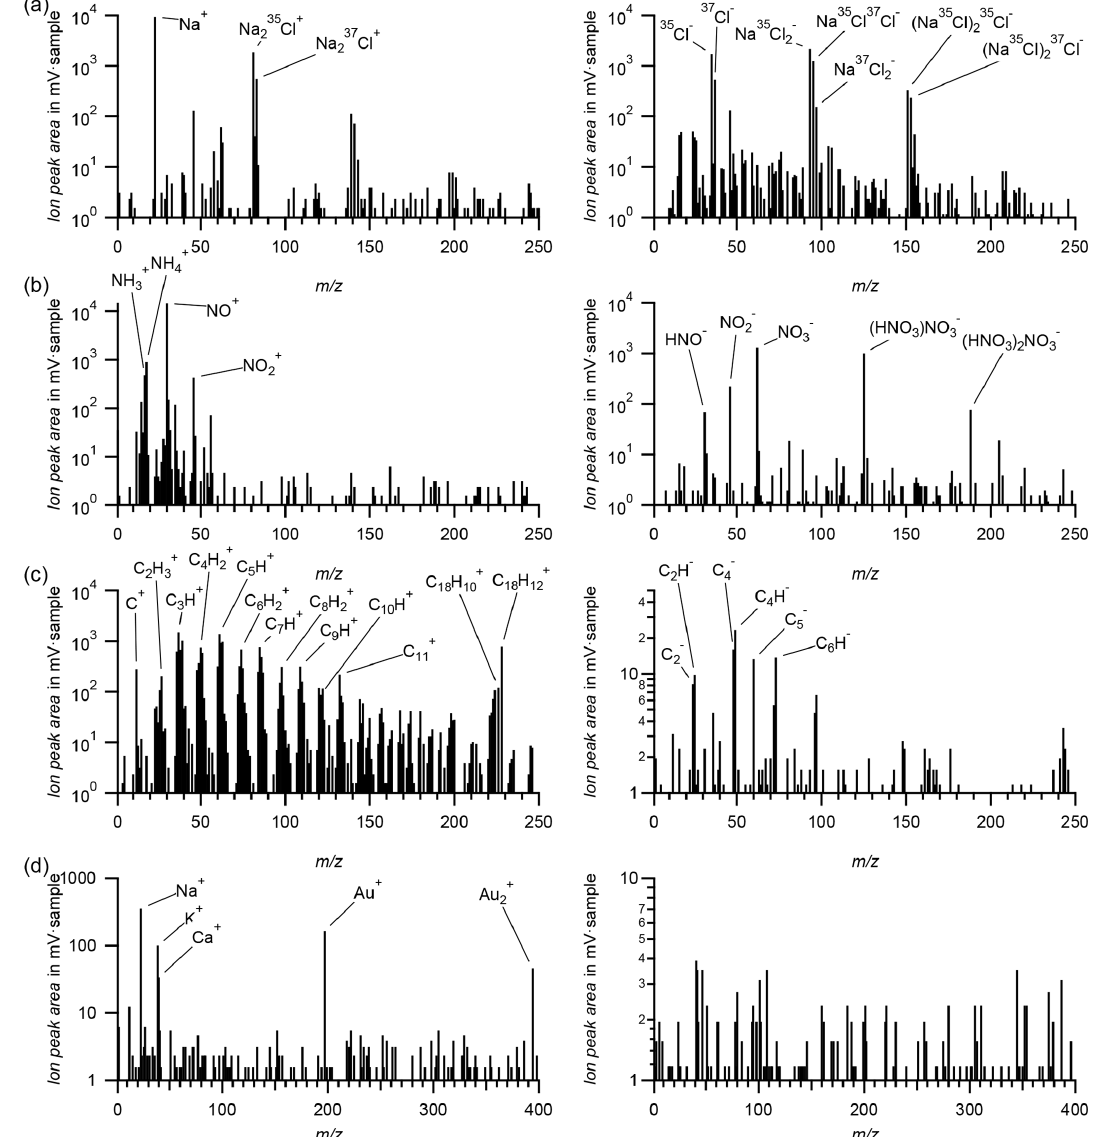
Figure 9. Exemplary stick mass spectra ( m/z ) of four laboratory-generated single particles as measured by the ERICA-LAMS. Left: cations; right: anions. (a) NaCl particle; (b) AN particle; (c) benz[a]anthracene (BaA) particle; (d) gold particle (note the abscissa for panel d is up to m/z 400; the anion shows no peak above the ion peak area threshold of